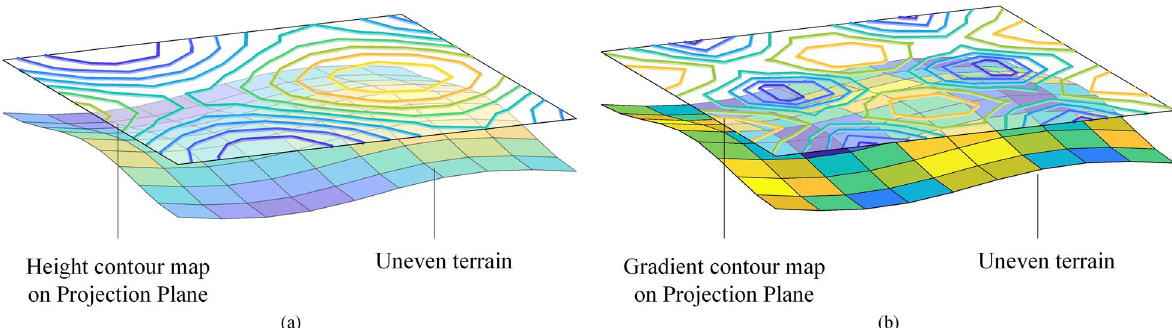
Figure 3 Diagram of terrain and projection plane: a contour map of ground height, b contour map of ground gradient